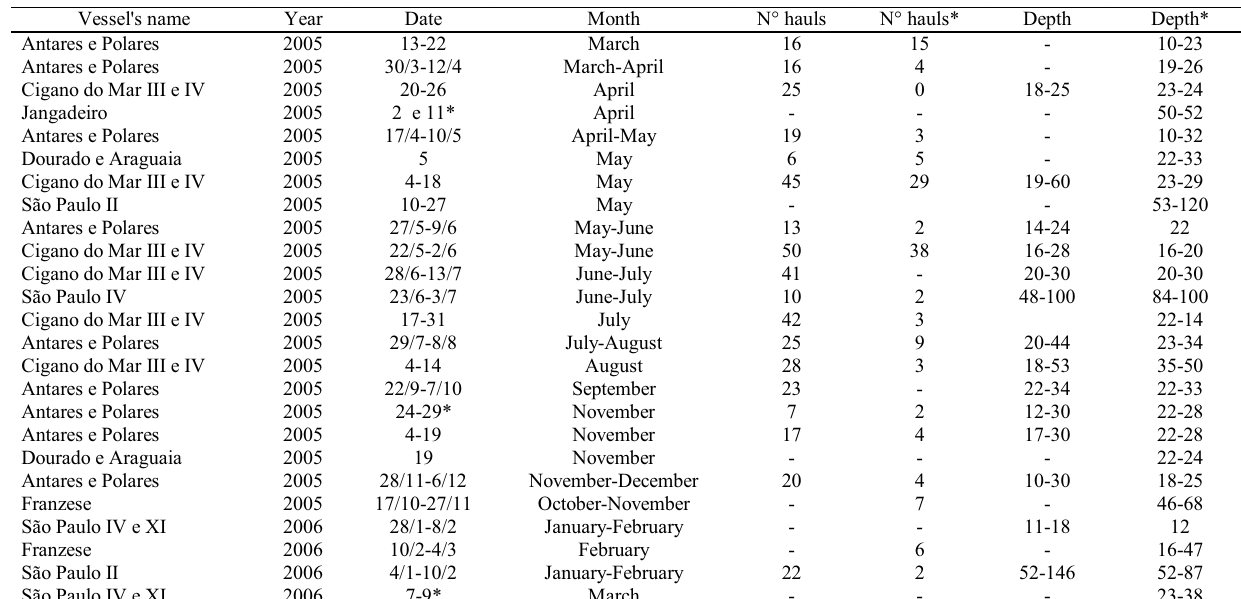
Table 1. Fishing trips carried out by eight fishery vessels of Guaruja´s (Southeast Brazil) fishing fleet conducted from March of 2005 to March of 2006 from which samples of Rioraja agassizi were obtained; name of the fishing vessels, date (days, month, year), number of hauls and number of hauls with presence of the species (*), depth of the hauls and depth with presence of the species (*). Days marked with (*) represent single days when Rioraja agassizi were collected, when this information was available. *dates where samples of Rioraja agassizi were collected; total trip days are unknown.